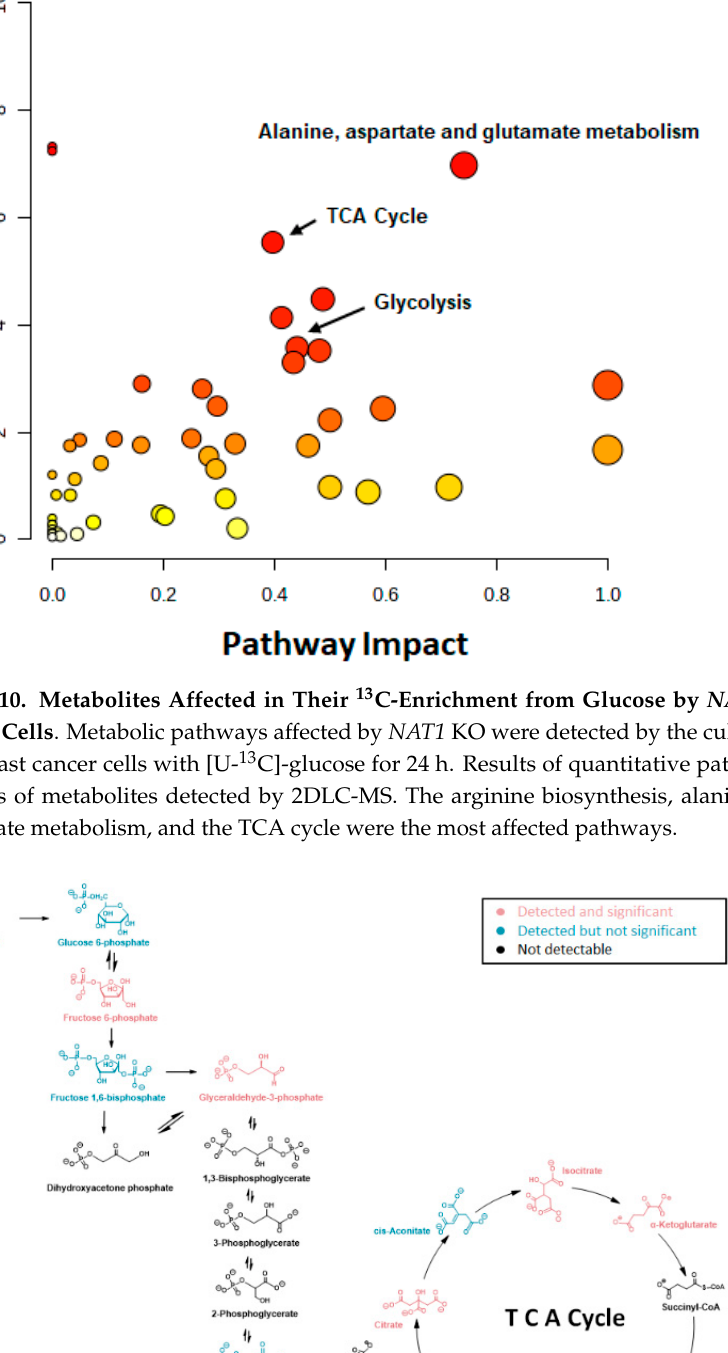
Figure 12. Alanine, Aspartate, and Glutamate Metabolites A ff ected in Their 13 C-Enrichment from Glucose by NAT1 KO in Breast Cancer Cells. Metabolites were detected in the alanine, aspartate, and glutamate biosynthesis pathways. Metabolites in black were not detected in this study, while the isotopologues of metabolites in pink showed signi fi cant abundance changes from NAT1 KO. Isotopologues of the metabolites in blue did not show signi fi cant abundance changes.